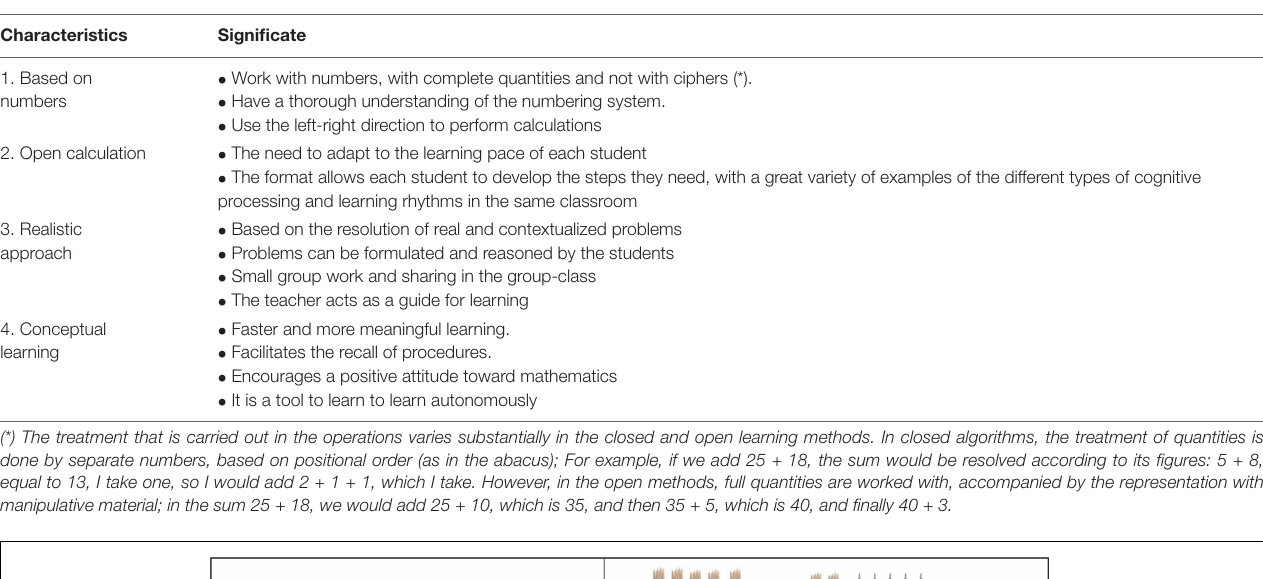
TABLE 4 | Characteristics of Open Algorithm Based on Numbers method.